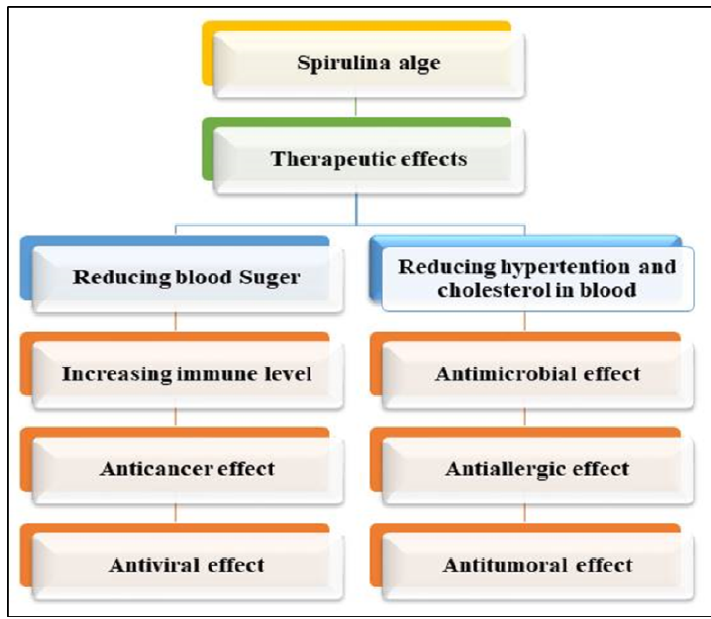
Figure 2. A diagrammatic explanation of the therapeutic value conferred by spirulina algae. Table 4. Biofunctional effect of spirulina algae biomass application.